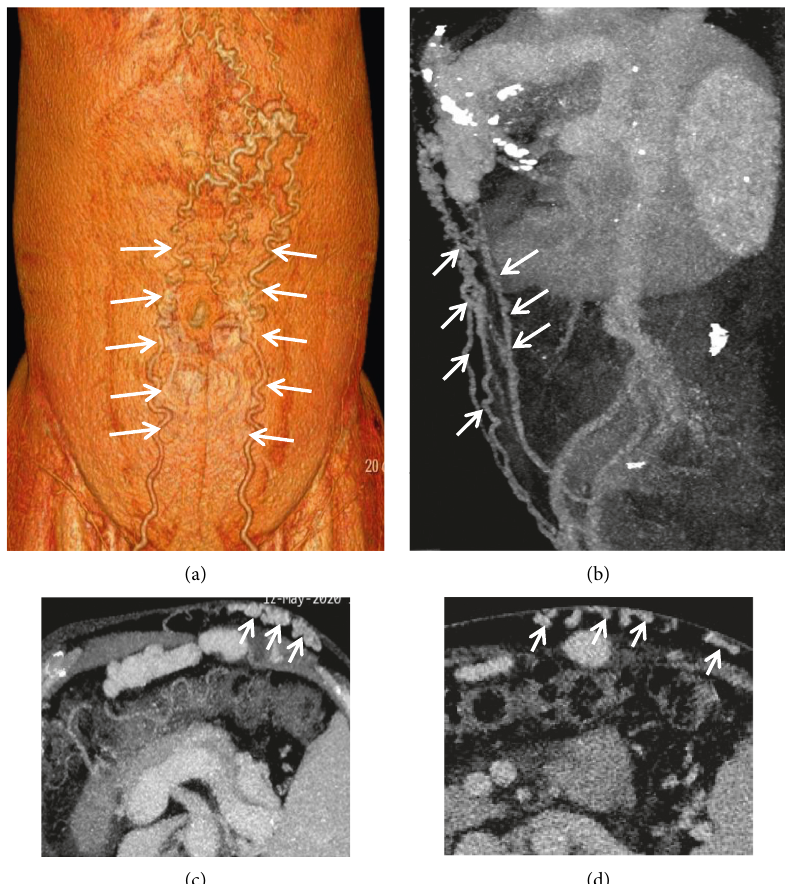
Figure 8: Abdominal wall varices. In a 65-year-old female with liver cirrhosis, the contrast-enhanced CT scan on the portal vein phase demonstrated that abdominal wall varices (white arrow) manifested as dilated, enhanced, and tortuous structures. (a) Three-dimensional reconstruction; (b) sagittal contrast-enhanced CT; (c, d) axial contrast-enhanced